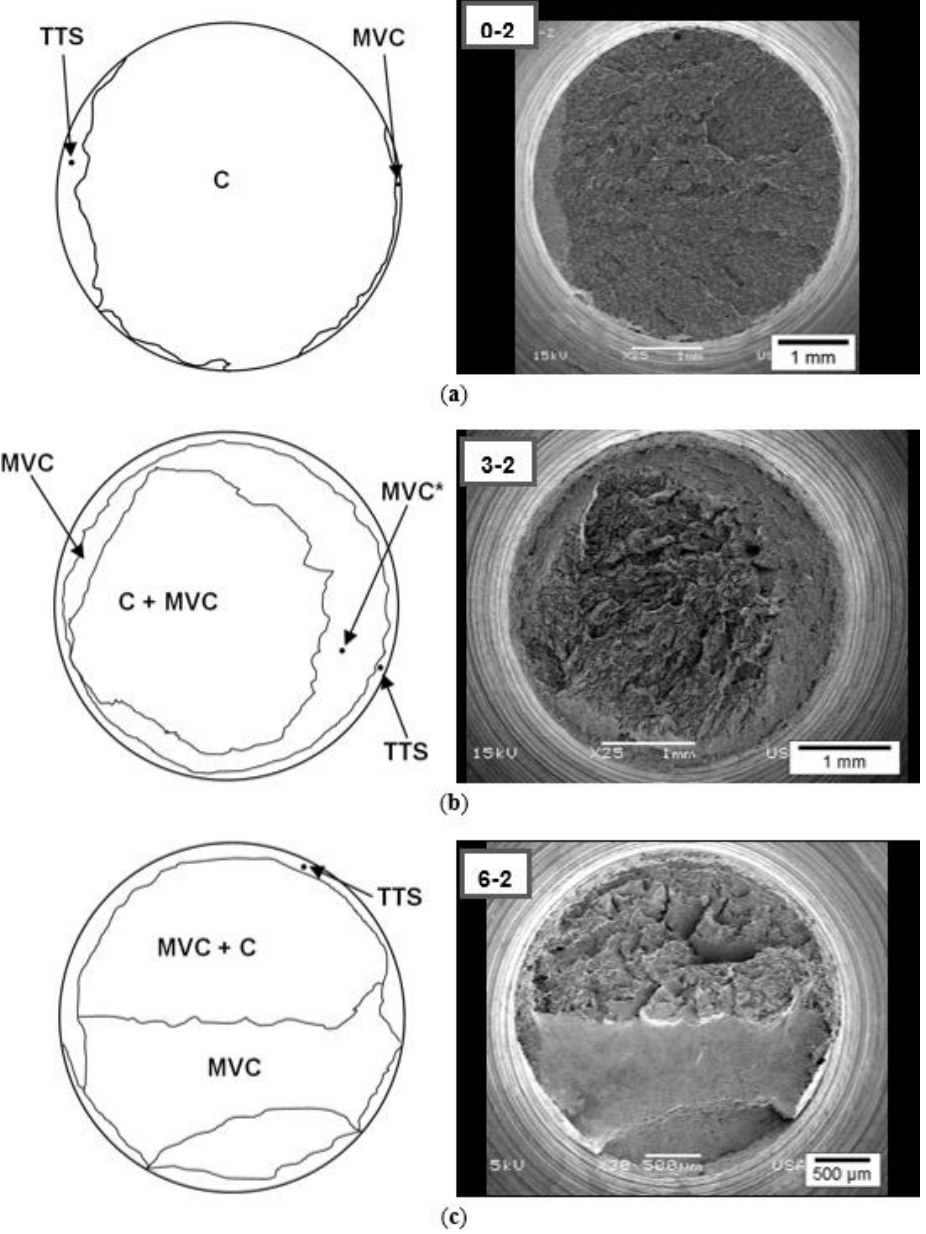
Figure 5. Micro-fracture maps (MFMs) for high loading rate (crosshead speed type 2 of 0.01 mm/min): ( a ) hot rolled steel (base material that is not cold drawn at all); ( b ) three drawing steps; ( c ) six drawing steps (heavily-drawn commercial prestressing steel).